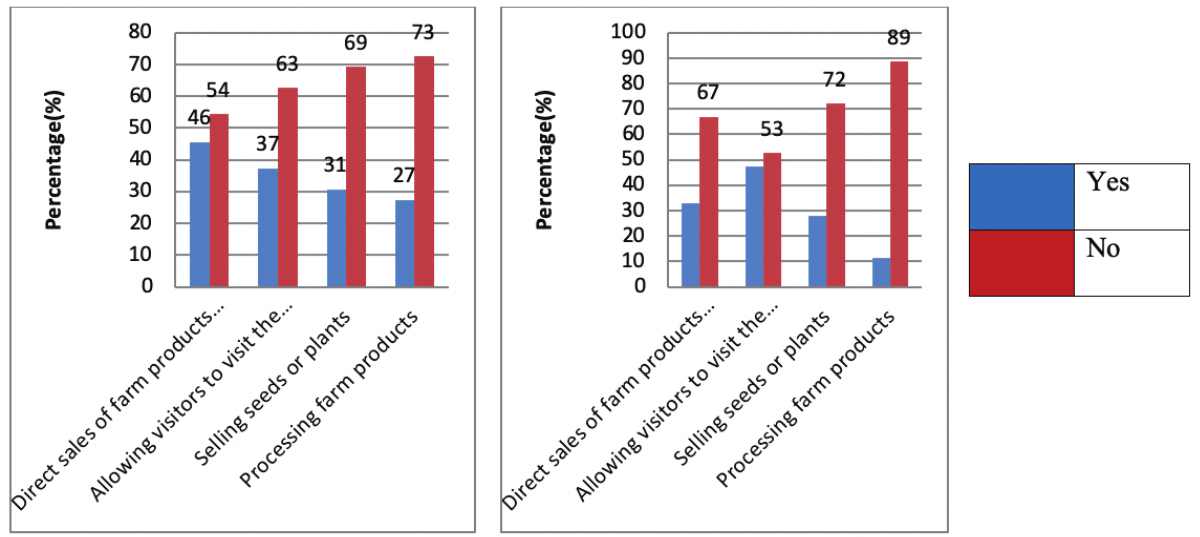
Figure 4: Agritourism activities practiced by the farmers in LCDZ Figure 5: Agritourism activities practiced by the farmers in UPWZ